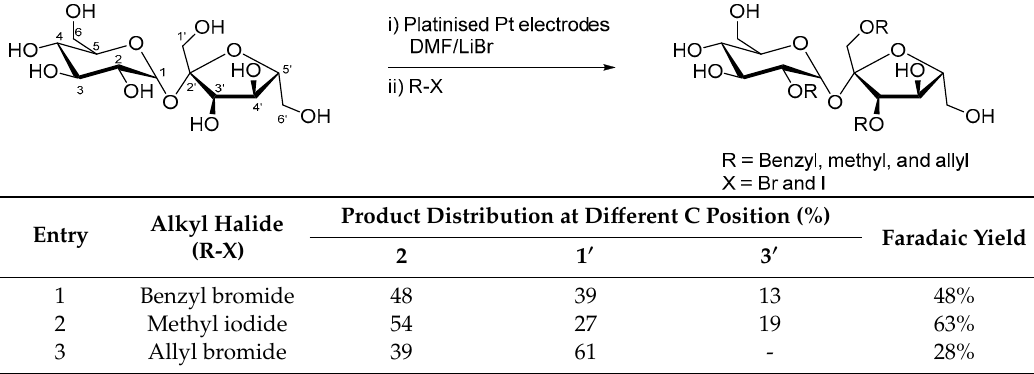
Table 10. Electrochemical alkylation of sucrose. Scheme 23. Electrochemical reduction of D -xylose ( 34 ).